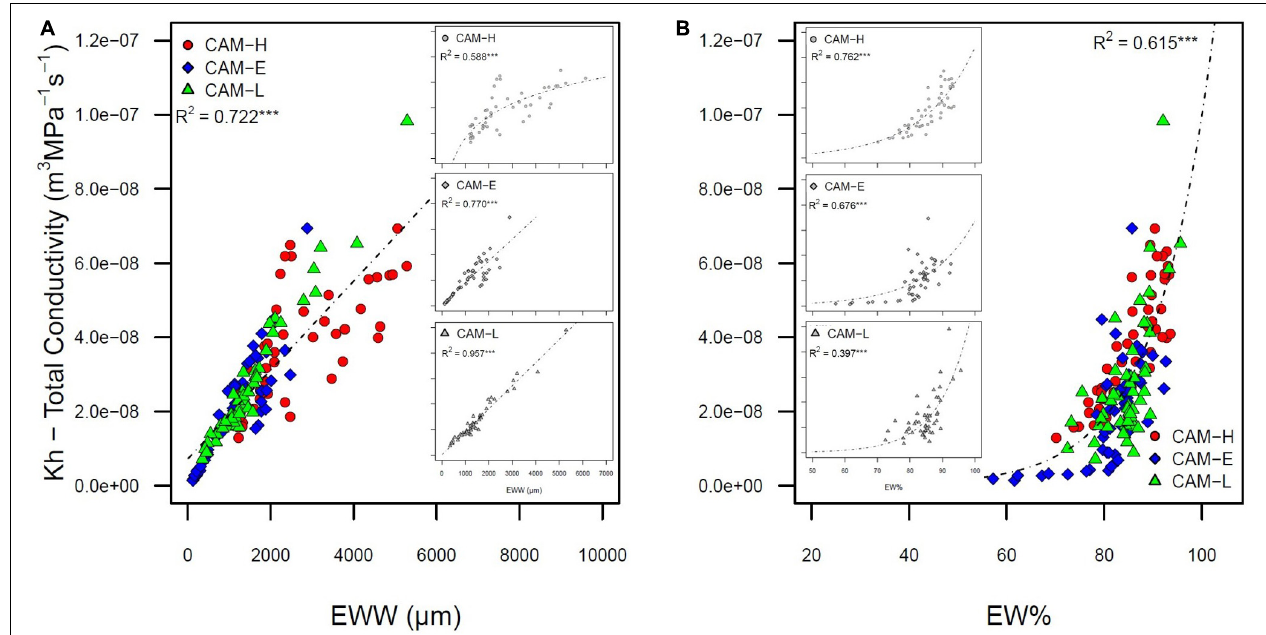
FIGURE 4 | (A) Total conductivity (Kh) as a function of earlywood width (EWW). The inset figures express the same relationship for each plot: CAM-H (top), CAM-E (middle), and CAM-L (bottom). A linear function was fitted, except in CAM-H where a logarithmic function shows the highest R 2 . (B) Total conductivity (Kh) as a function of earlywood percentage (EW%). The inset figures express the same relationship for each plot: CAM-H (top), CAM-E (middle), and CAM-L (bottom). An exponential function was fitted. Each symbol (circle, diamond, and triangle) corresponds to a tree from the three plots CAM-H (red), CAM-E (blue), and CAM-L (green). All relations are significant (*** P < 0.001).